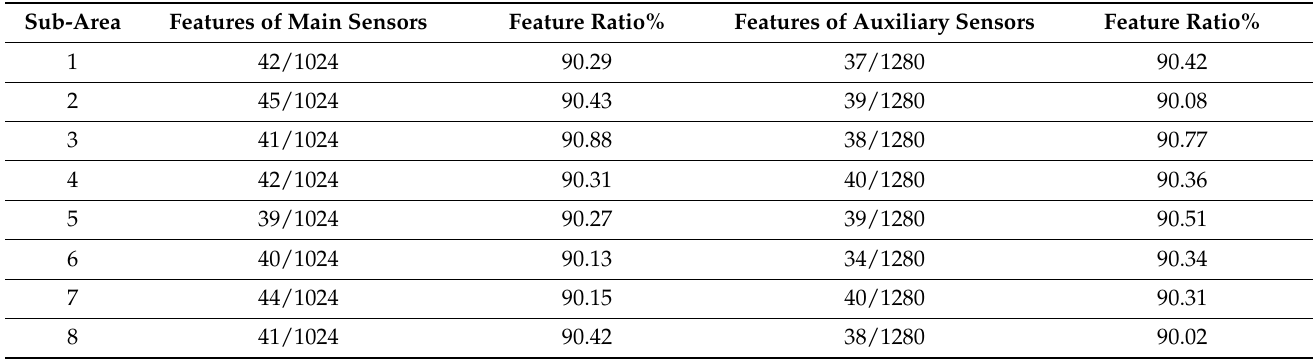
Table 3. The length of principal component analysis (PCA) features and feature ratio in eight sub-areas. Sub-Area Features of Main